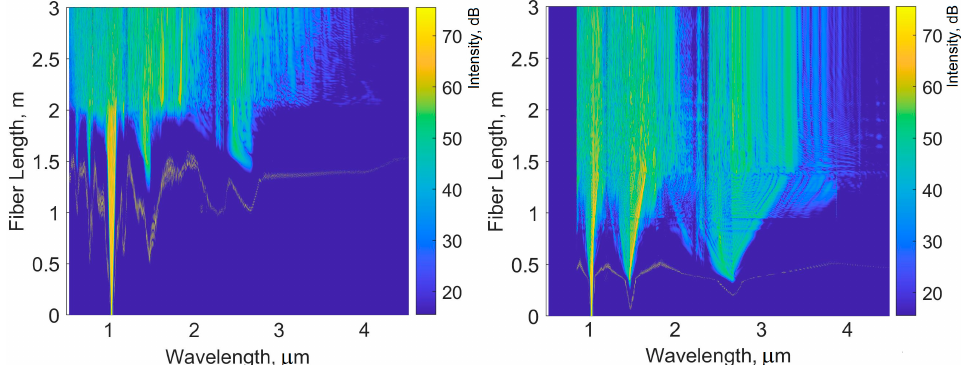
Figure 8. Numerical simulations of the spectral evolution. The energy of the pump pulses coupled to the HCF was 50 µ J. The input pulses had a duration of 1 ps with the chirp value of C = 4. The pressure of gaseous D 2 was 50 atm. The figure on the right was obtained for the case when anti-Stokes generation was intentionally blocked in the simulations.